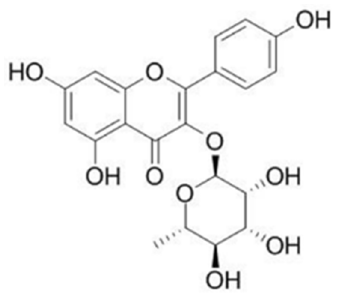
Figure 1. The structure of afzelin.